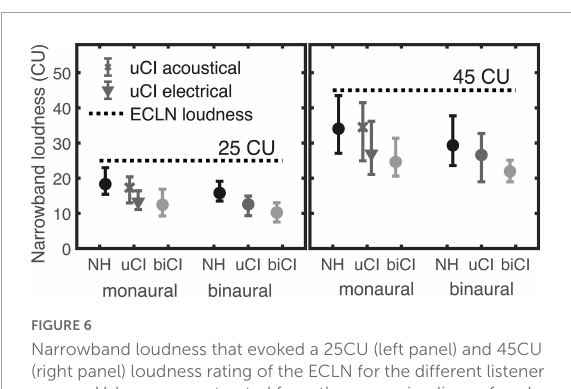
FIGURE6 Narrowband loudness that evoked a 25CU (left panel) and 45CU (right panel) loudness rating of the ECLN for the different listener groups. Values were extracted from the regression lines of each listener and the error bars show mean and range of the